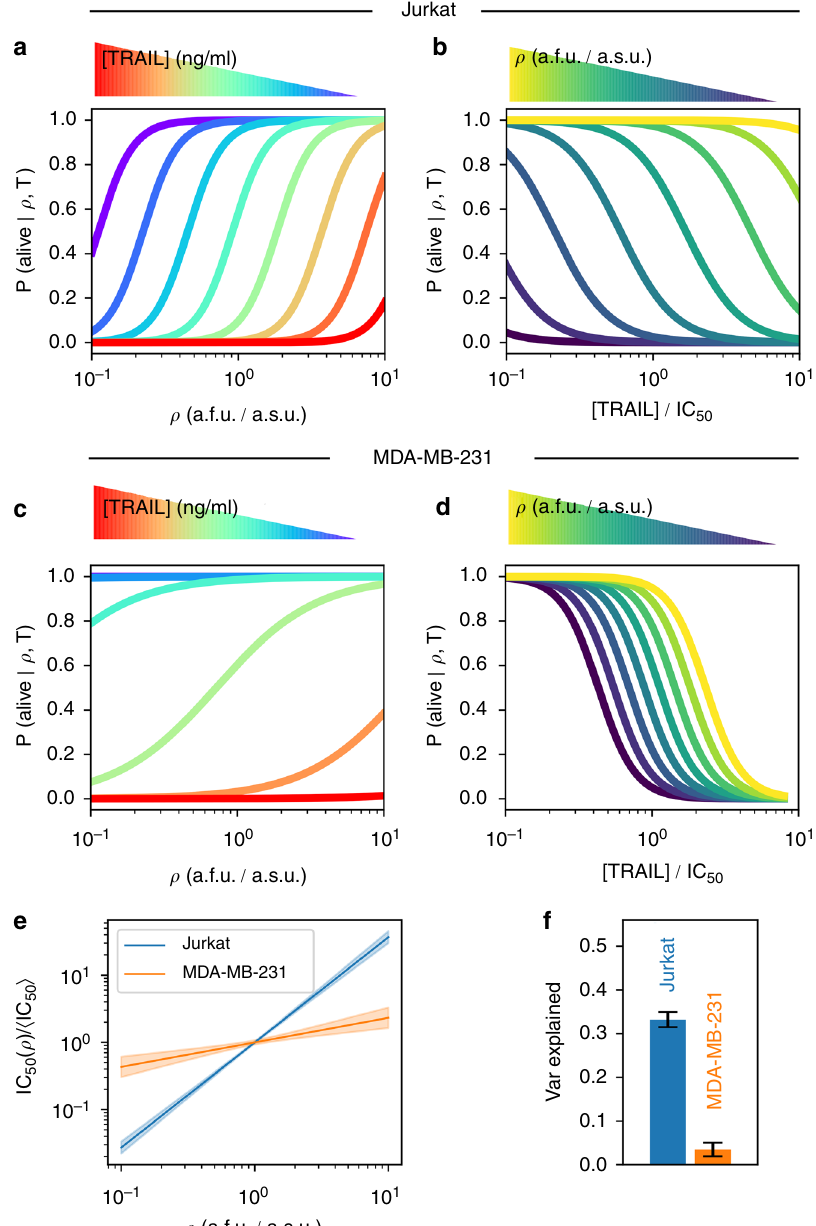
Fig. 4 CCV in mitochondria density in fl uences fractional response to TRAIL. The inferred fractional response determined by the single-cell Hill model and the average model parameters, over triplicate experiments, for Jurkat cells ( a , b ) and MDA-MB-231 cells ( c , d ) as a function of ρ and TRAIL dose, respectively. ( e ) The dependence of single-cell sensitivities to TRAIL as a function of mitochondria abundance computed from the inferred model parameters. f The fraction of the variance in single-cell TRAIL sensitivities explained by CCV in mitochondria density. Error bars represent standard error of the mean of experimental triplicates. Detailed analysis of each replicate set are presented in Supplementary Figs. 5 –